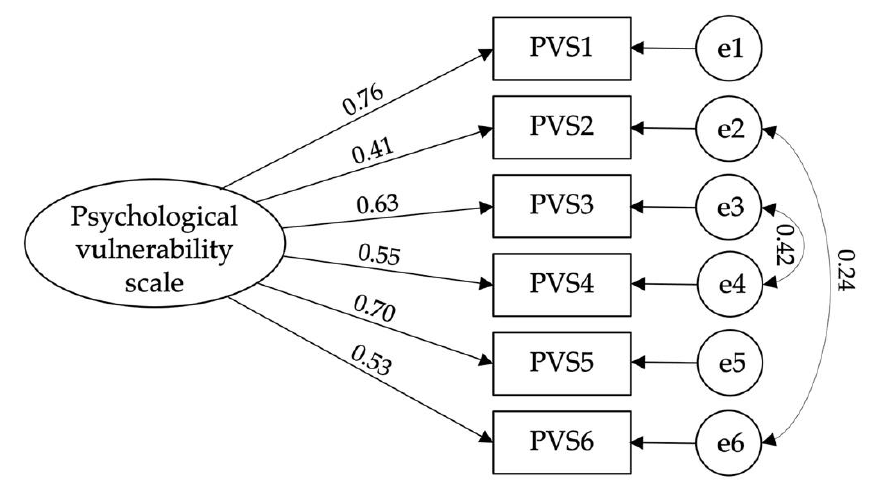
Figure 3. Model fit of Hostility Scale.